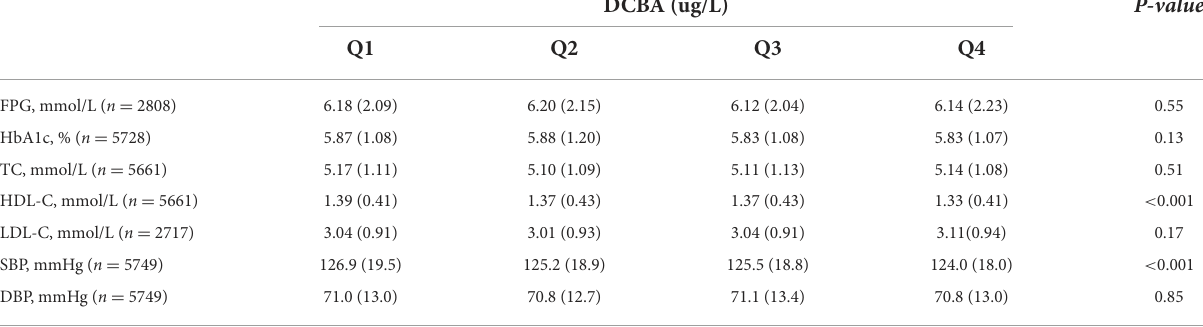
TABLE 2 Cardiovascular risk factors in terms of quartiles of differences in DCBA, NHANES 2007–2014.